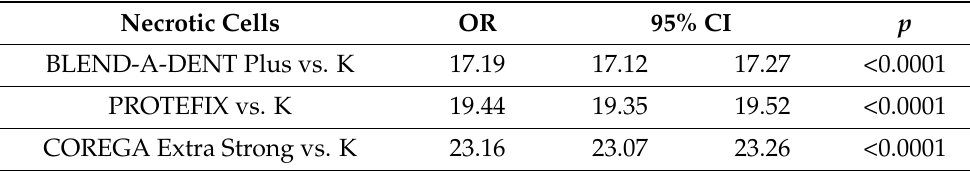
Table 4. Risk of detecting of necrotic cells in study groups versus control